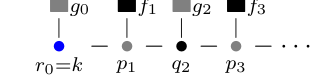
Figure 5. Possible NS5-D6-O6-D8-O8 brane con(cid:12)gurations and the linear quivers they engineer.